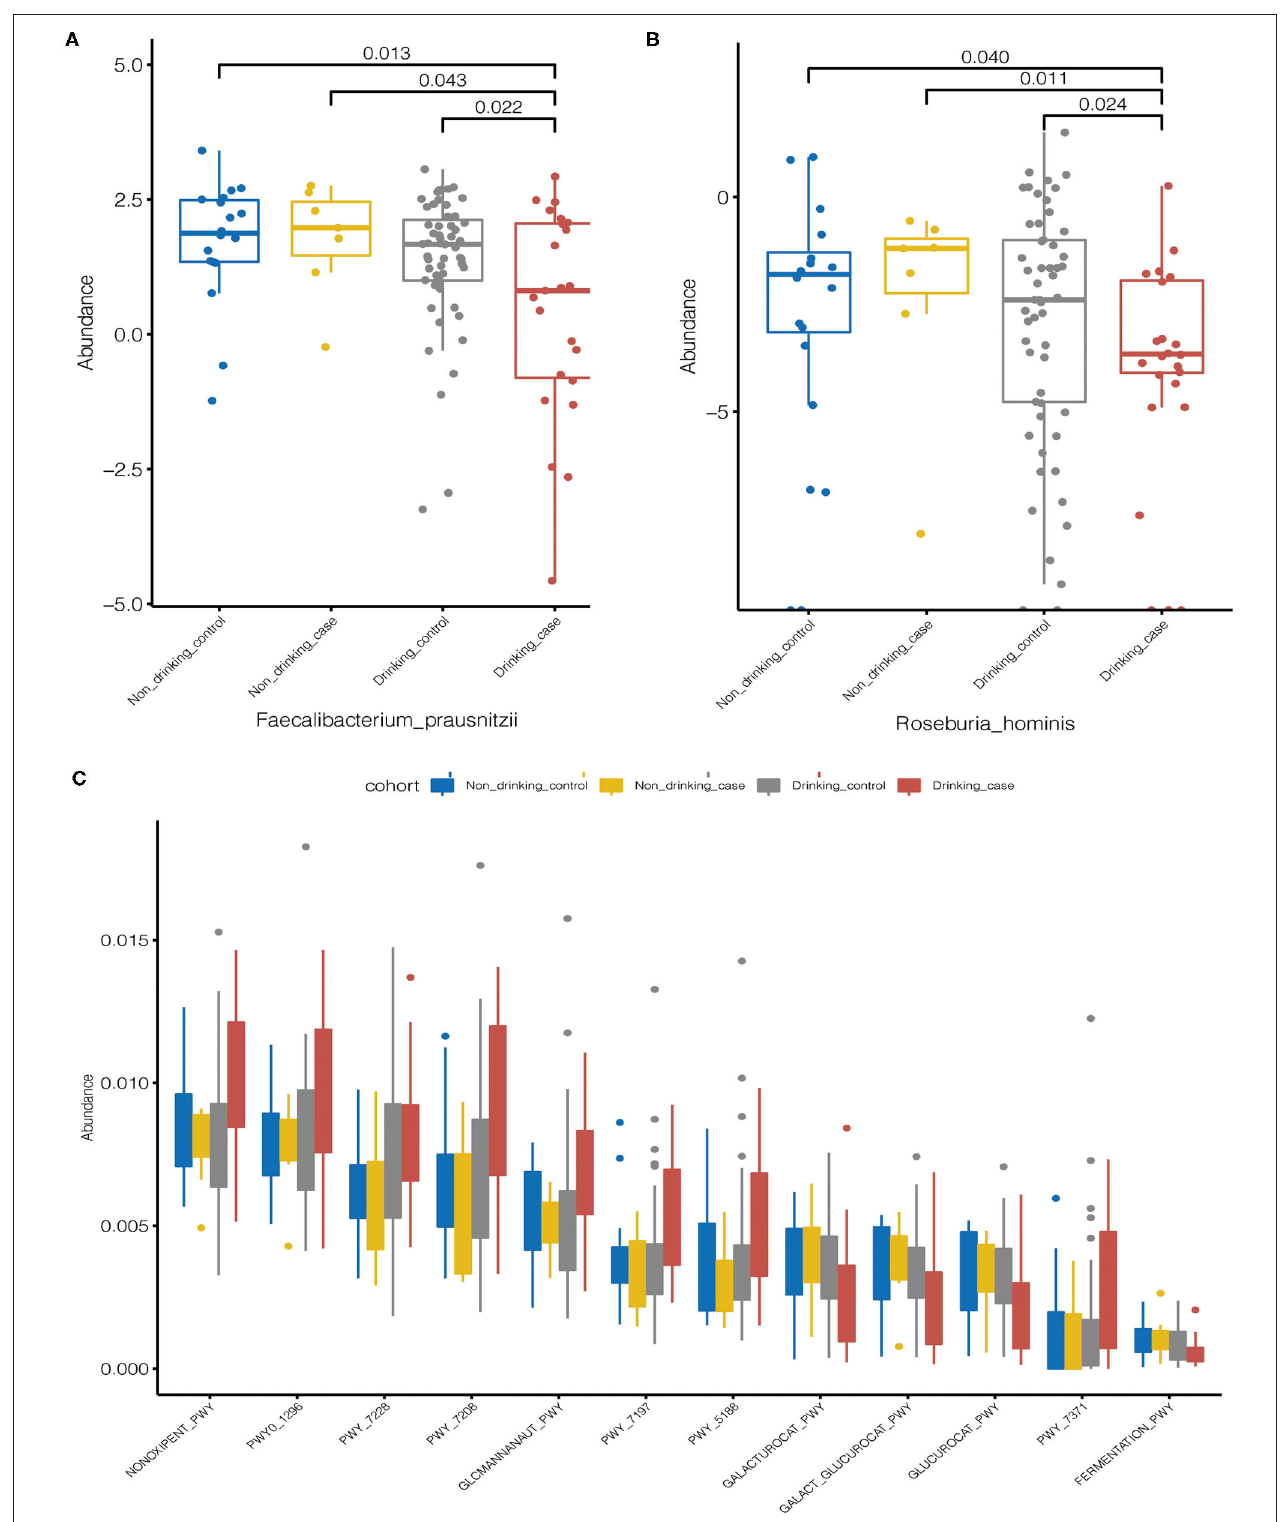
FIGURE 5 | Statistically differential species and metabolic pathways among the four groups. (A,B) The distribution of the statistically differential species ( Faecalibacterium prausnitzii and Roseburia hominis ); (C) The distribution of the statistically differential metabolic pathways.